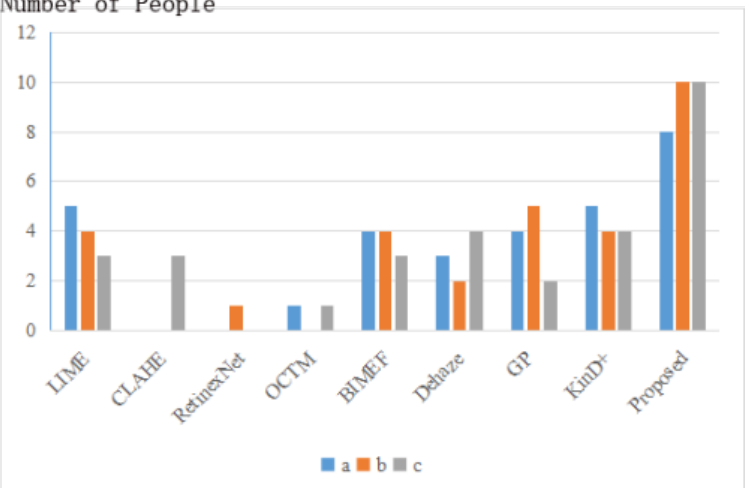
Figure 10. Subjective evaluation of enhanced results. a, b, c represent the enhancement results of three different real low light images shown in Figure